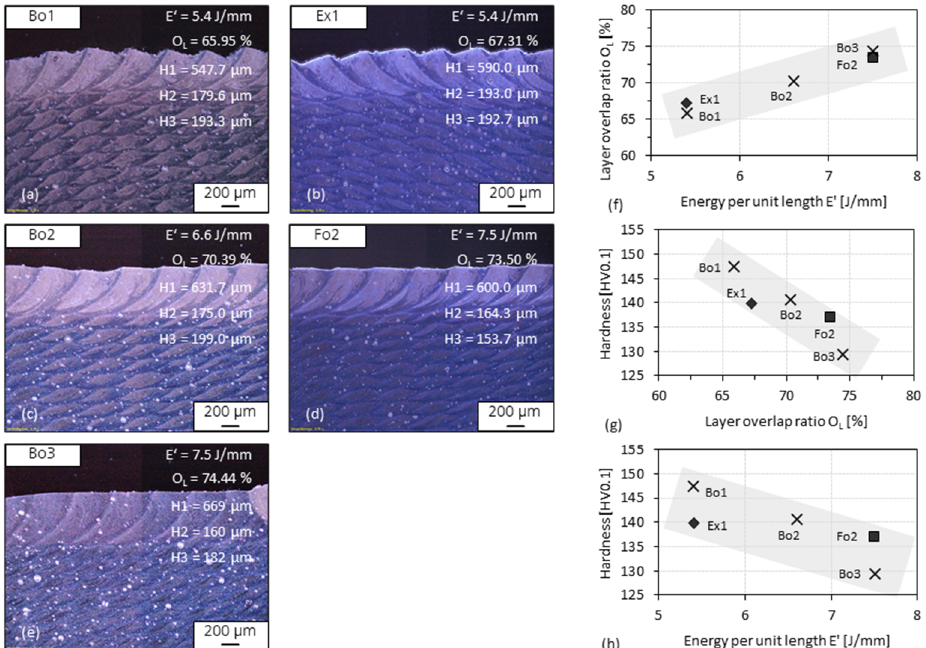
Figure 15. Microscopic dark field images of the etched specimen cross-section of ( a ) Bo1, ( b ) Ex1, ( c ) Bo2, ( d ) Fo2, and ( e ) Bo3. ( f ) Plot graph of layer overlap ratio O L against energy per unit length E’. Plot graphs of hardness against layer overlap ratio O L ( g ) and energy per unit length E’ ( h ). The thickness H1, H2, and H3 marked in ( a – e ) are each the average value of three measurements. Each hardness data point represents the average of 30 indentations. The specimens had been aged at 325 °C for 4 h.